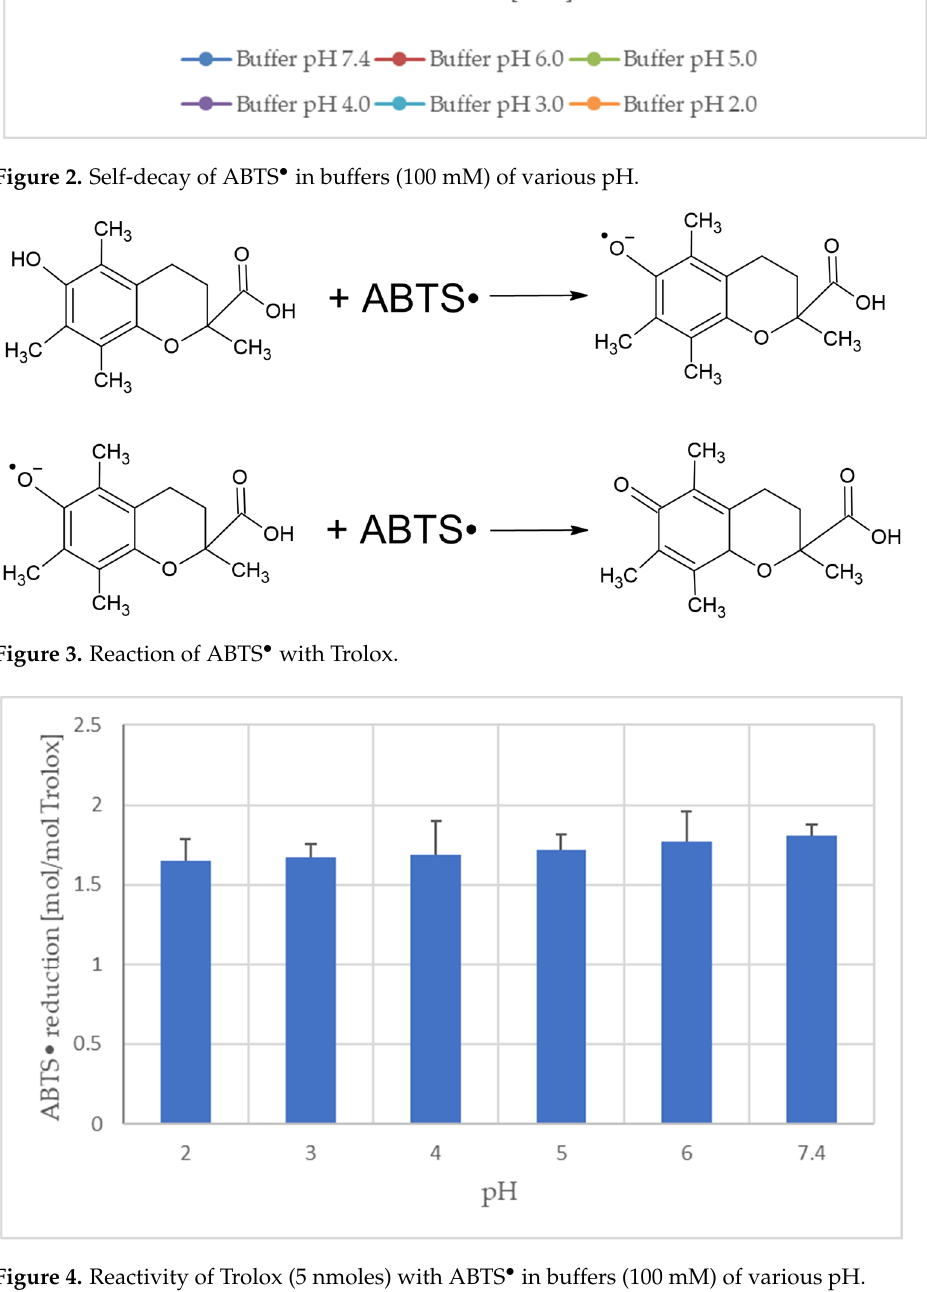
Figure 4. Reactivity of Trolox (5 nmoles) with ABTS • in buffers (100 mM) of various pH.